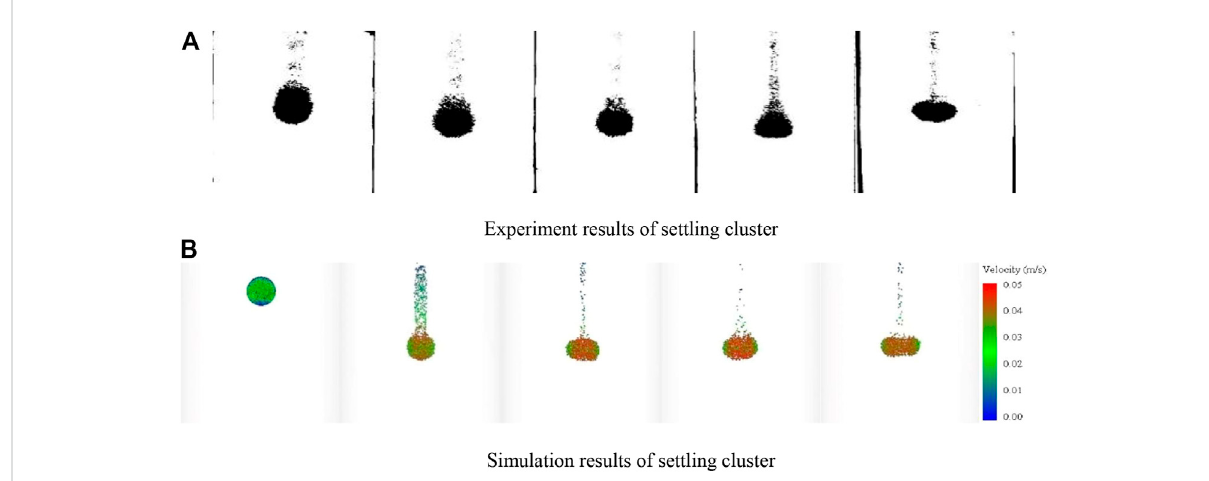
FIGURE 4 Shape and velocitychangerules of theclusterin 95% glycerol. (A) Experimentresults ofsettling cluster. (B) Simulation results ofsettlingcluster.